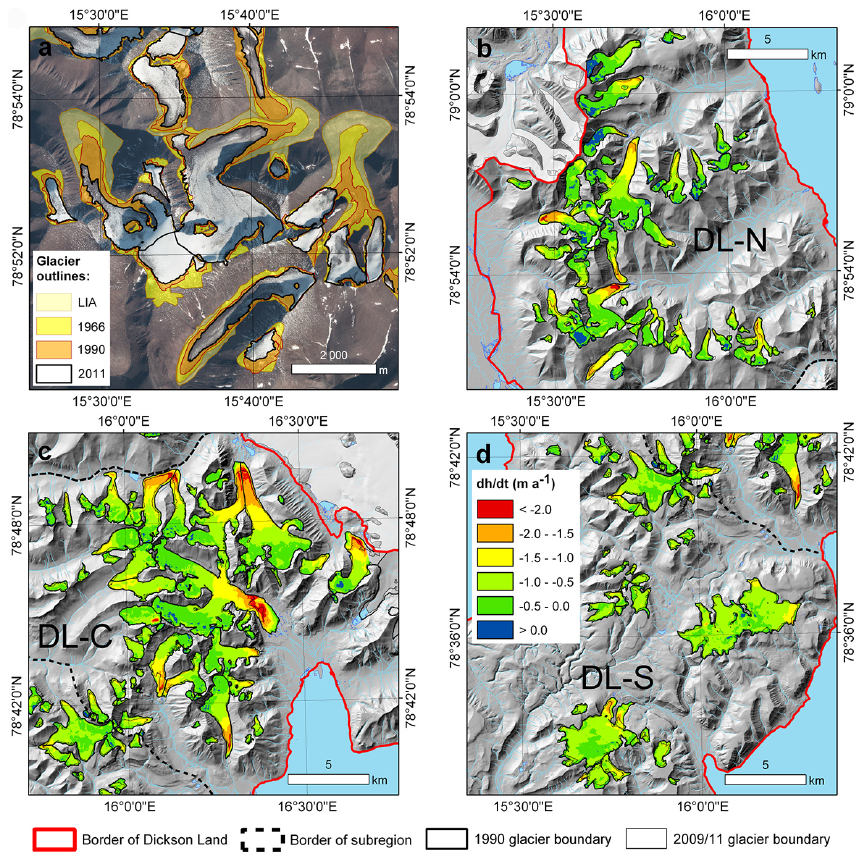
Figure 5. An example of glacier area changes in northern Dickson Land in the Vasskilbreen region (a) ; the mean 1990–2009/2011 elevation change rates in northern (b) , central (c) , and southern (d) Dickson Land. Orthophotomap for (a) © Norwegian Polar Institute.